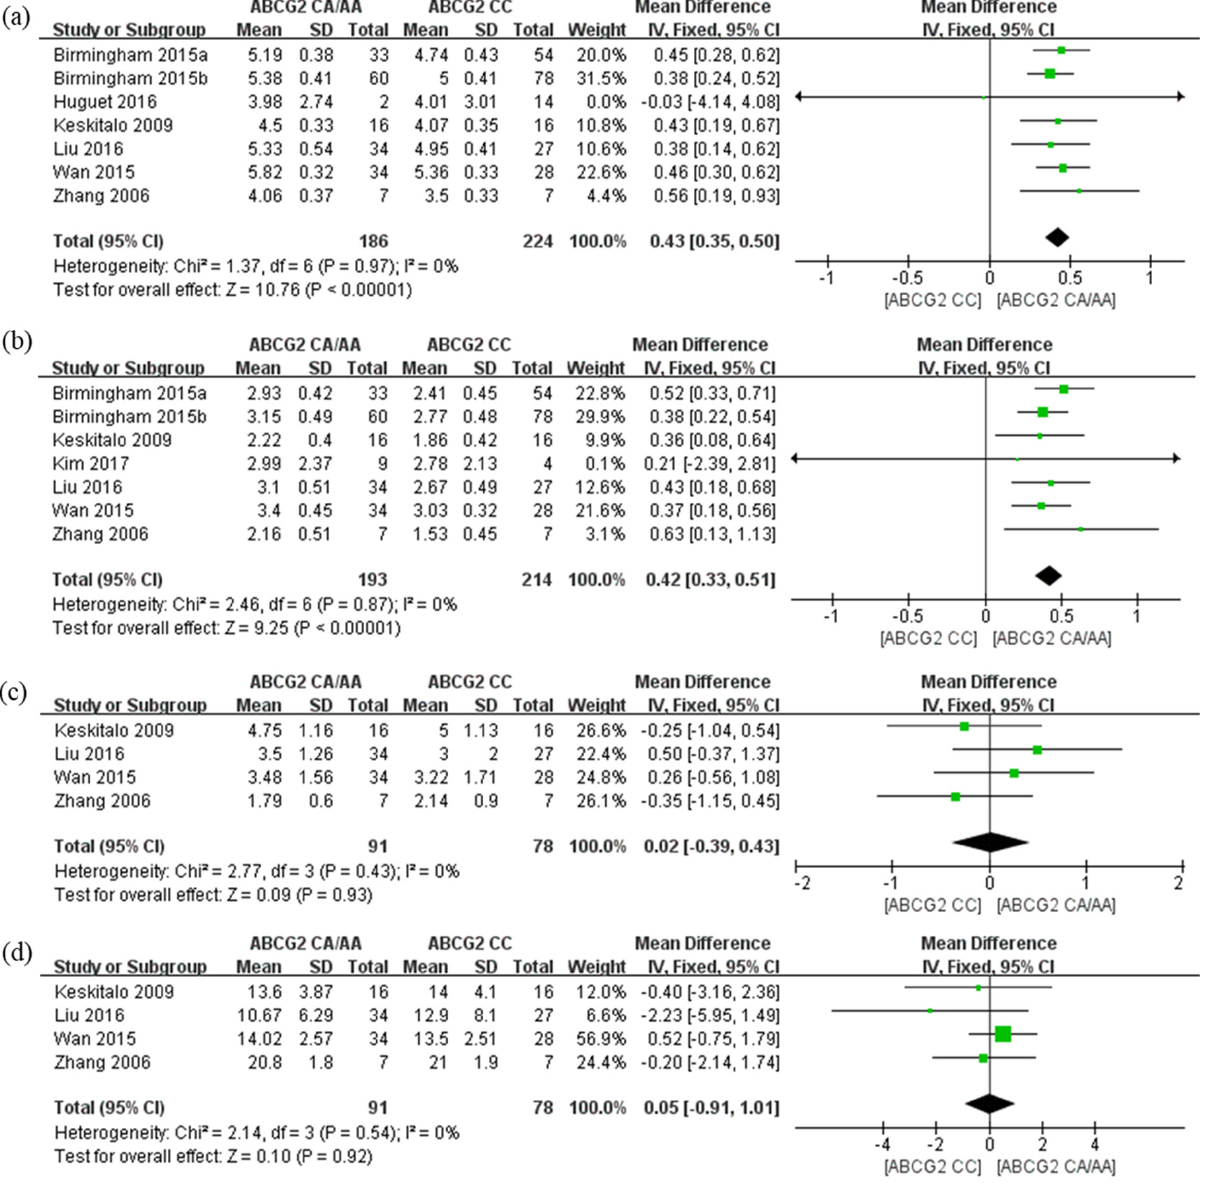
Figure 2. Forest plots of the effects of ABCG2 421C>A on rosuvastatin; values expressed as logarithm of geometric mean for ( a ) AUC 0- ∞ and ( b ) C max ; arithmetic mean differences for ( c ) T max and ( d ) half-life. The effect size for each individual study is represented by the green square and the overall pooled effect size is represented by the black diamond.